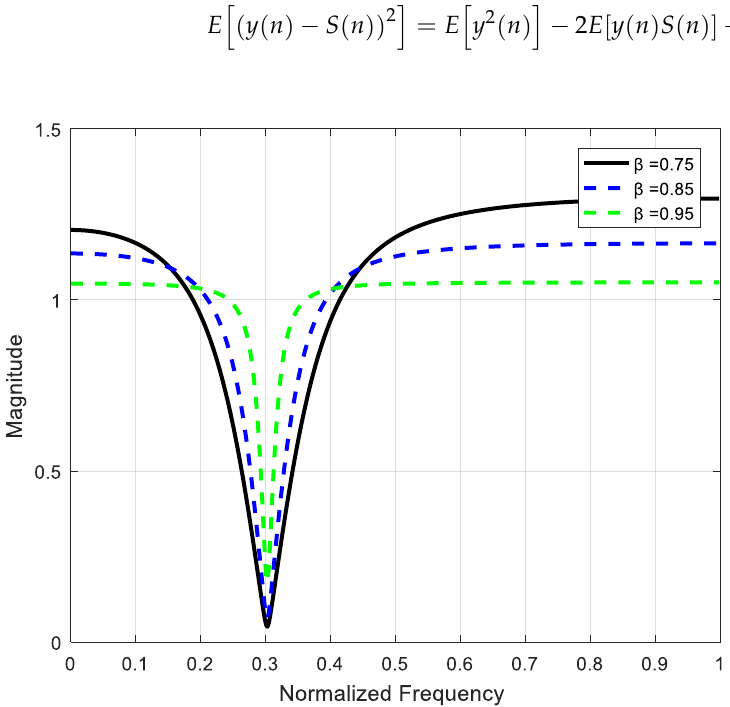
Figure 7. Characteristics of the notch related to filter parameters: notch width vs. β .